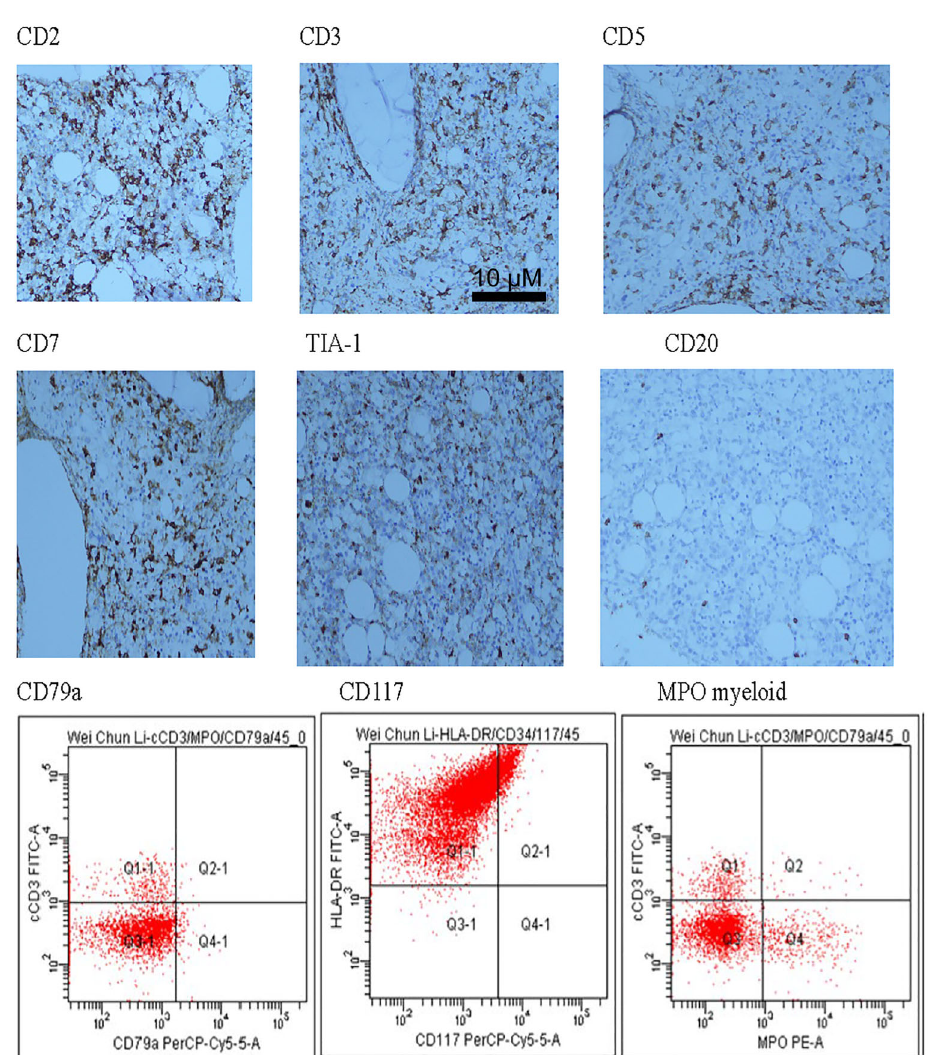
Figure 3. Pathologic and immunohistochemical analysis showing hematopoietic tissue between bone marrow scattered mass. Speci fi c cells with patchy distribution, in which cells ranged in size from small to medium, nuclei were pale, enlarged, and irregular including thin karyotheca, inconspicuous nucleoli, partly visible nucleoli, and interstitial fi brous tissue hyperplasia. Atypical cells CD2, CD3, CD5, CD7, and TIA-1 were found positive, CD20, CD79a, and CD117 were found negative, and MPO myeloid cells were found positive. Bar: 10 μ M. Diagnosis: Lesions conformed to abnormal proliferation of bone marrow T lymphocytes. The case was considered to be T-cell lymphoma involving the bone